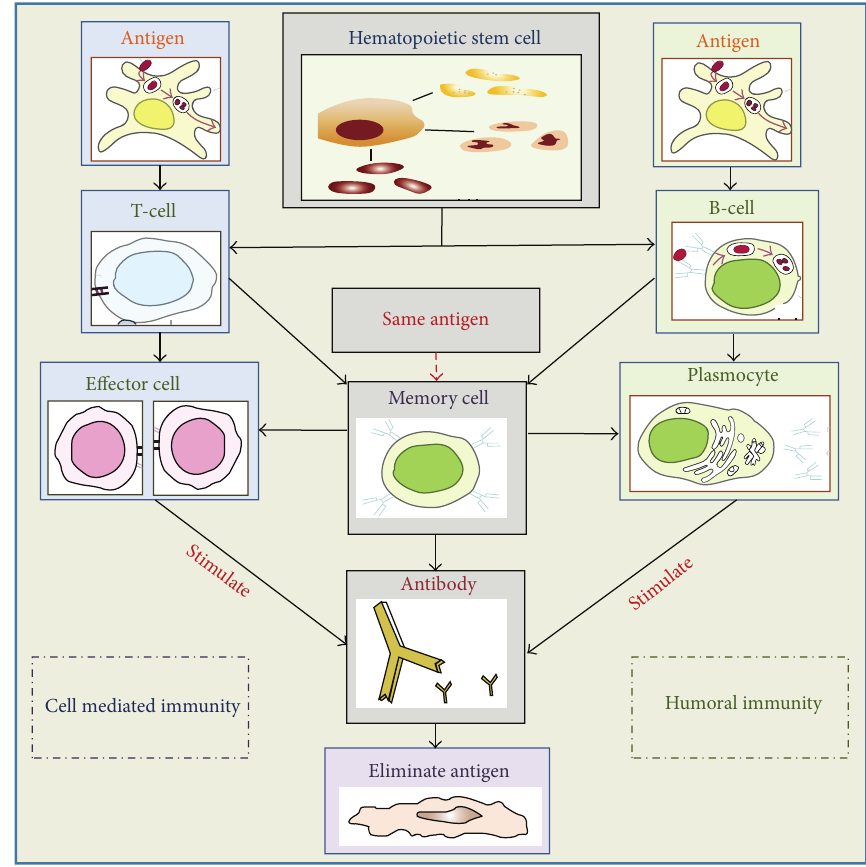
Figure 2: Abstract model of immune